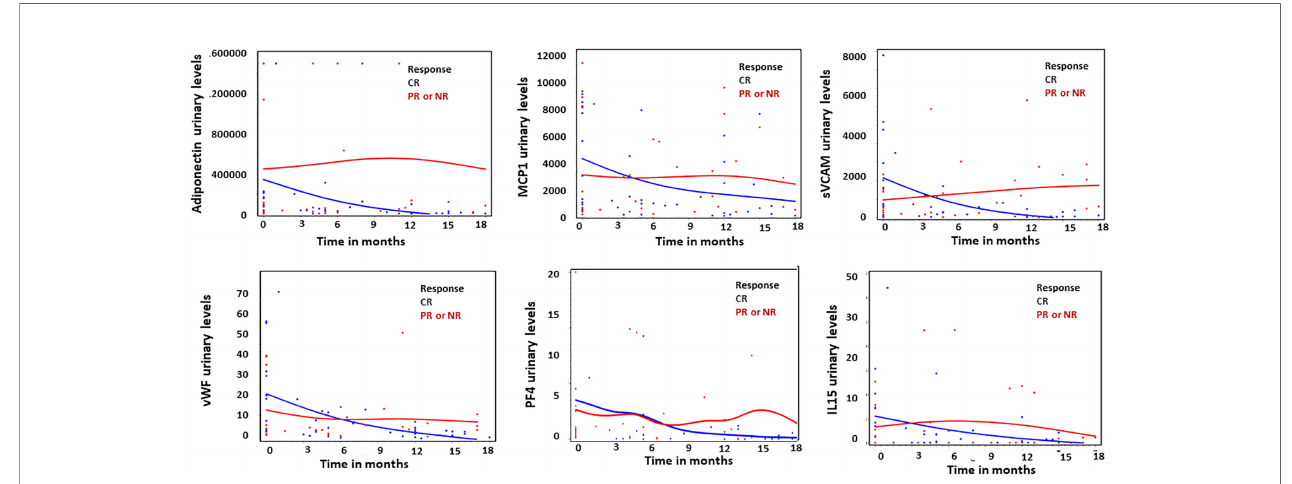
FIGURE 1 | Thumbnail plots illustrating the difference in the amount of urinary biomarkers over time between complete responders (CR; n = 12, blue) and partial or non responders (PR or NR; n = 9, red). Units for all graphs are in pg/ m mol, except PF4 expressed in ng/ m mol.